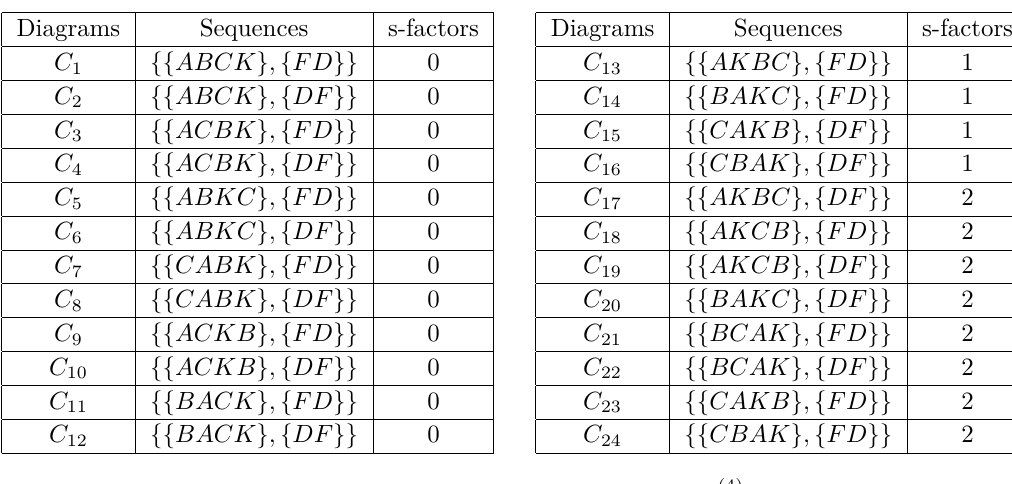
Table 19. Normal ordered diagrams of Cweb W (4)